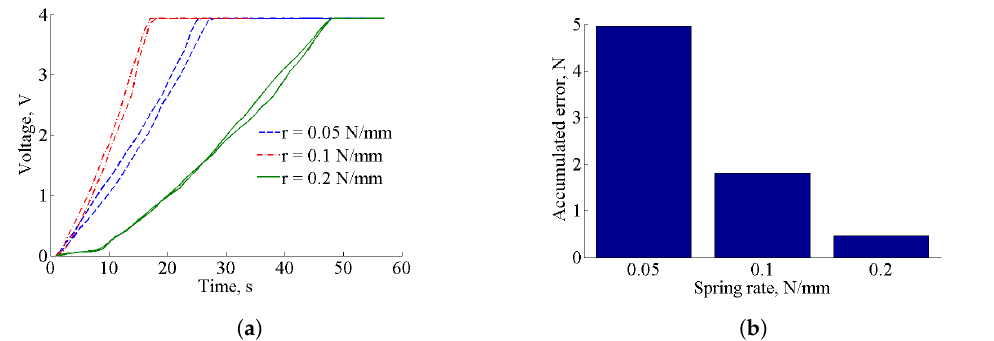
Figure 9. Performance of the hysteresis for liner springs. ( a ) Hysteresis curves for force elements with different spring rates; ( b ) Accumulated errors for hysteresis loops for force elements with different spring rates.